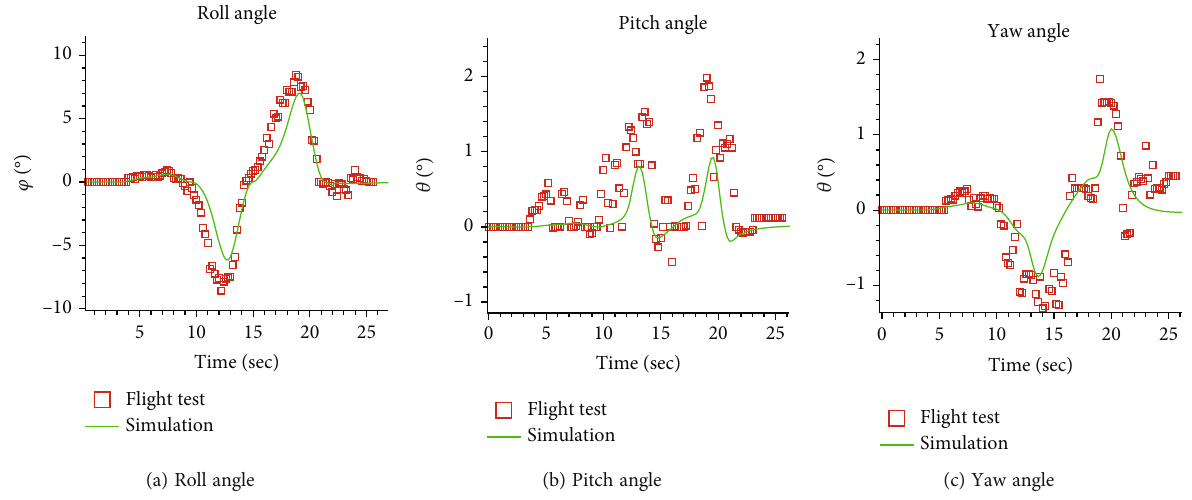
Figure 20: Comparison between the Euler angles of Quad-Plane in fl ight simulation and fl ight